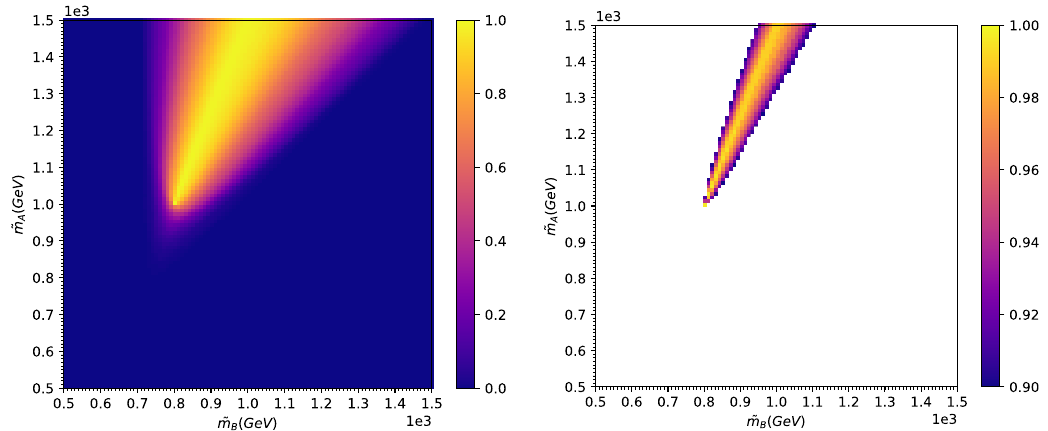
Figure 7 . Solvability heat maps for (cid:12)xed ~ m plane we show the fraction of events which are solvable. The plot on the right considers only mass points which solve over 90% of the events (note the change of scale in the